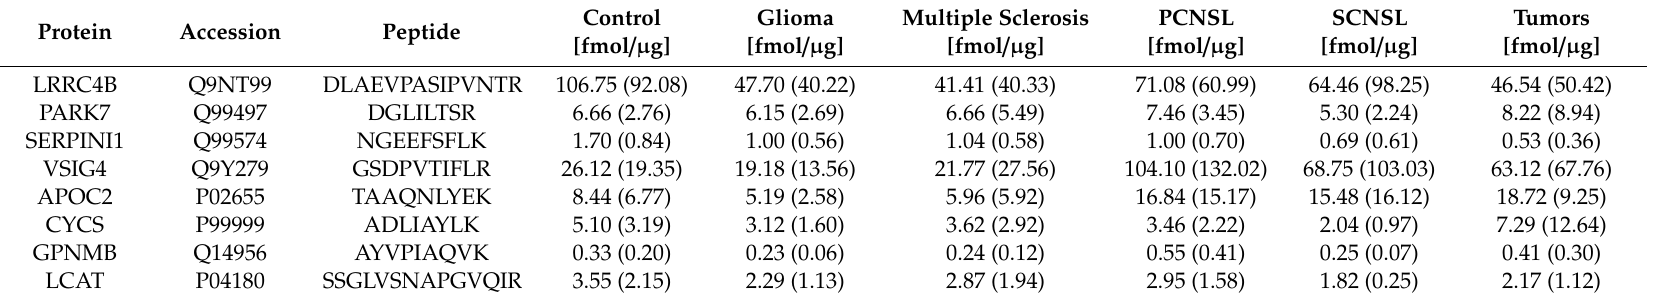
Table 5. Concentration of candidate peptide biomarkers determined in the validation cohort. The standard deviation of the biomarker peptides concentration in CSF is given in brackets.